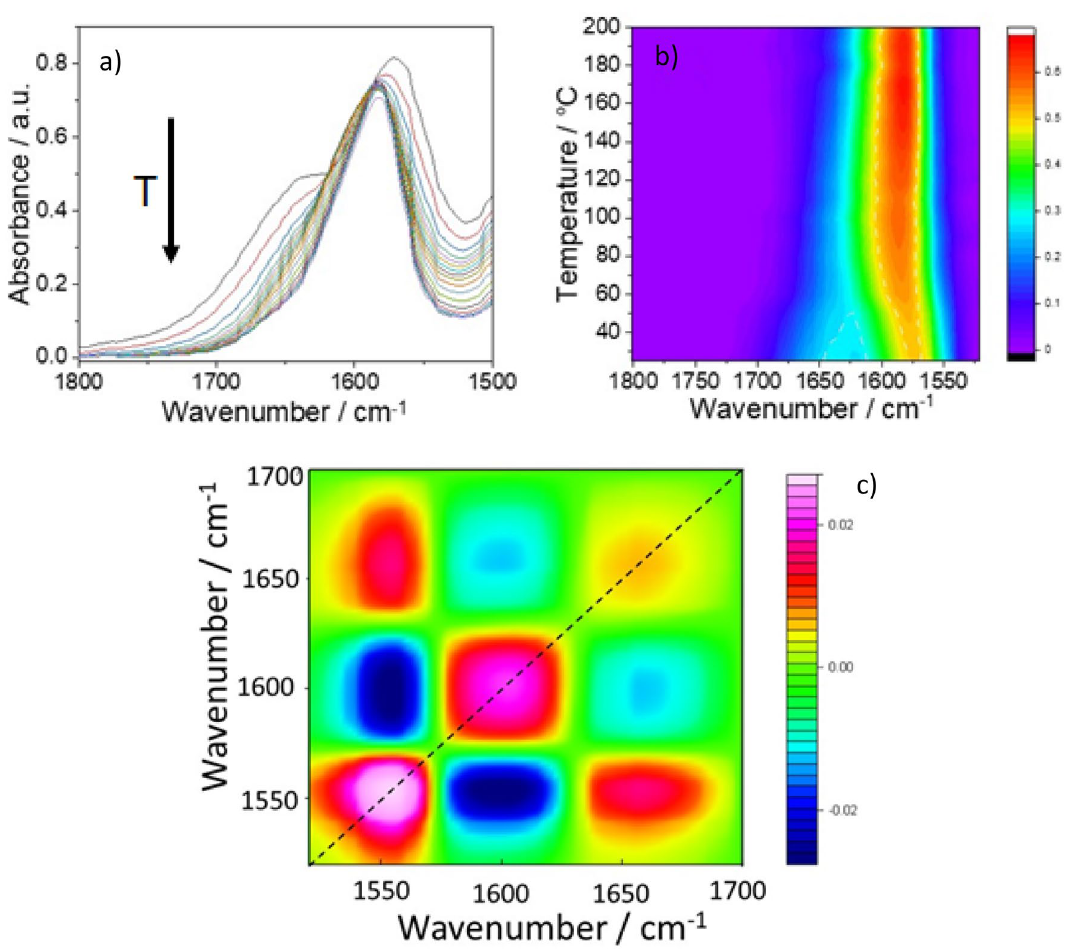
Figure 8. ( a ) FTIR absorption spectra of the pH 13 samples obtained by HT at 200 °C in the 1800–1200 cm −1 range and recorded in situ at increasing temperatures, from 25 up to 200 °C. ( b ) 3D map of the FTIR spectra, wavenumber (X-axis)–temperature (Y-axis)–intensity (false color scale). ( c ) 2D IR correlation asynchronous spectra; the intensity is shown in a false color